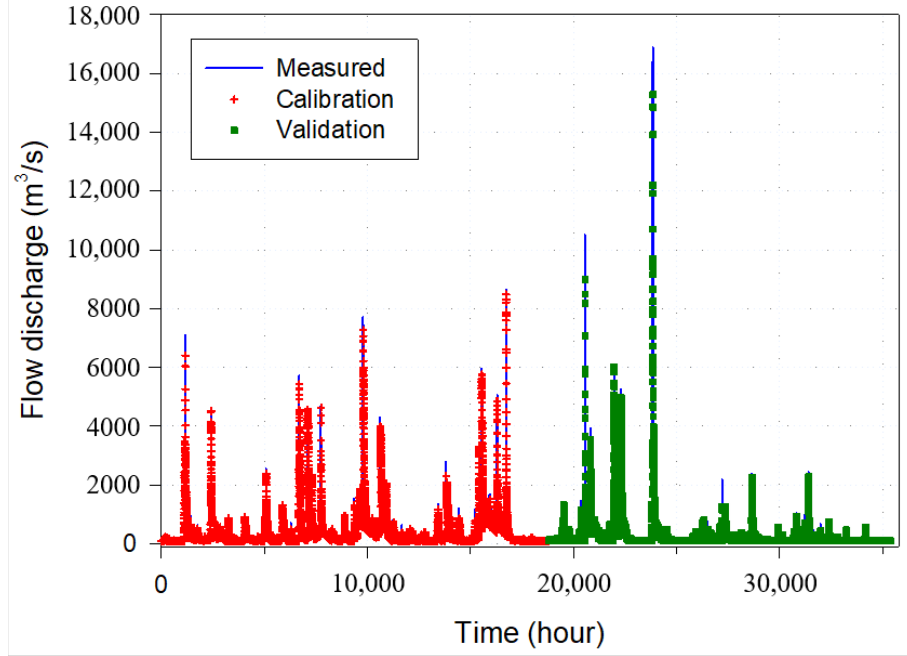
Figure 3. Calibration and validation of the measured and simulated flow discharge at the Chunyun